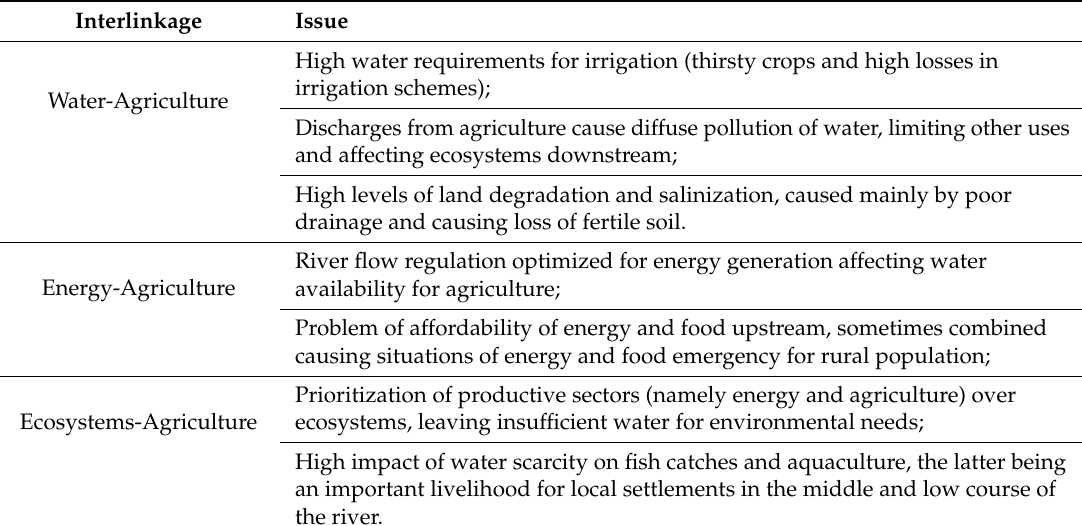
Table A3. Intersectoral Issues in the Syr Darya River